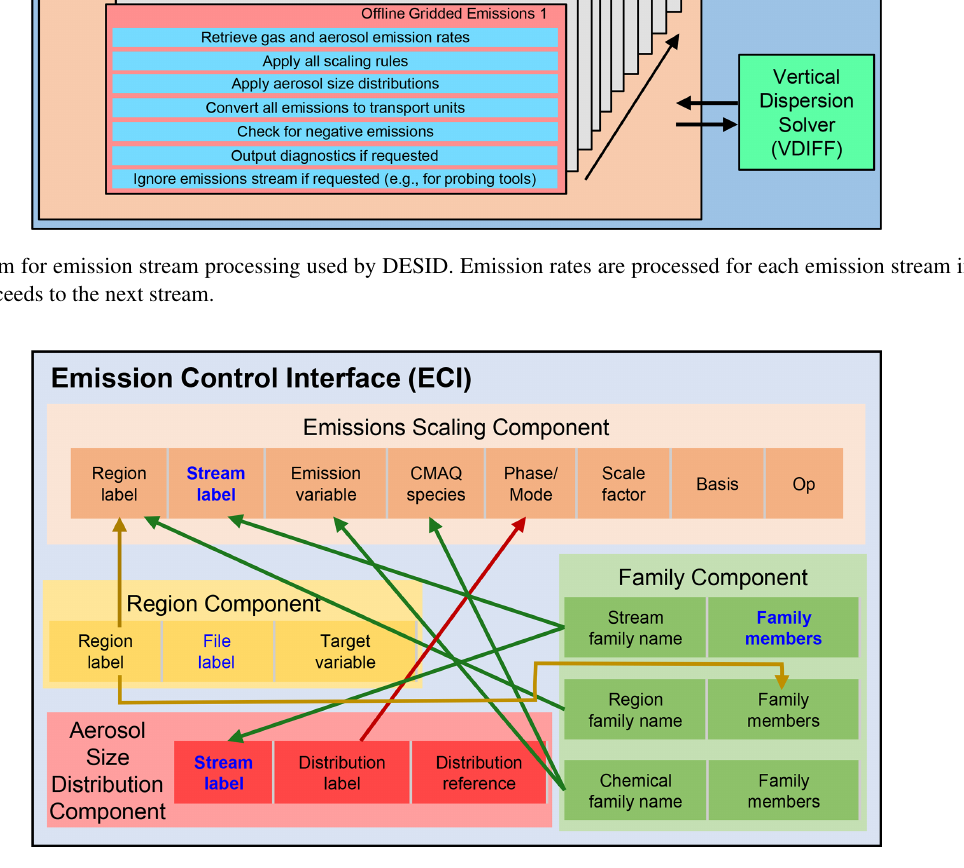
Figure 4. Schematic of Emission Control Interface (ECI) and flow of input options among individual components. Information flow lines are colored based on the component of origin. Text in blue indicates elements that should refer to environment variables set in the CMAQ runscript except in the case where stream labels are populated from the Family component with members that then refer to the runscript. The “Distribution reference” of the Aerosol Size Distribution component refers to entries populated within the CMAQ source